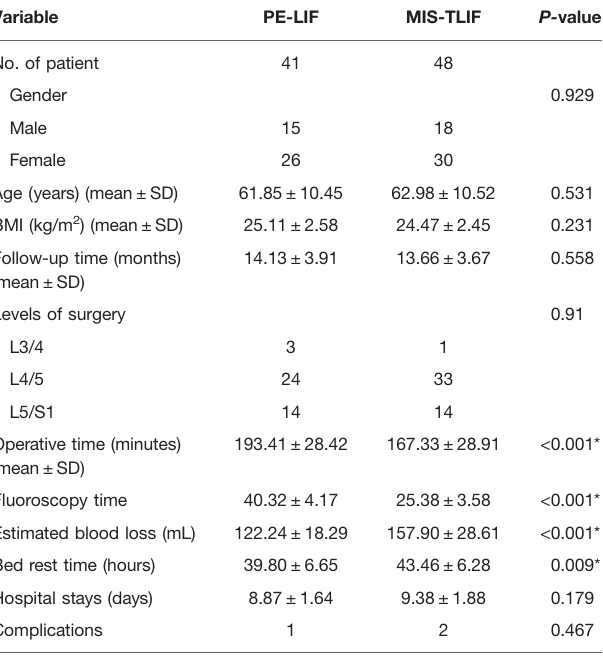
TABLE 2 | Preoperative and postoperative visual analogue scale (VAS), Oswestry disability index (ODI) scores and Modi fi ed MacNab